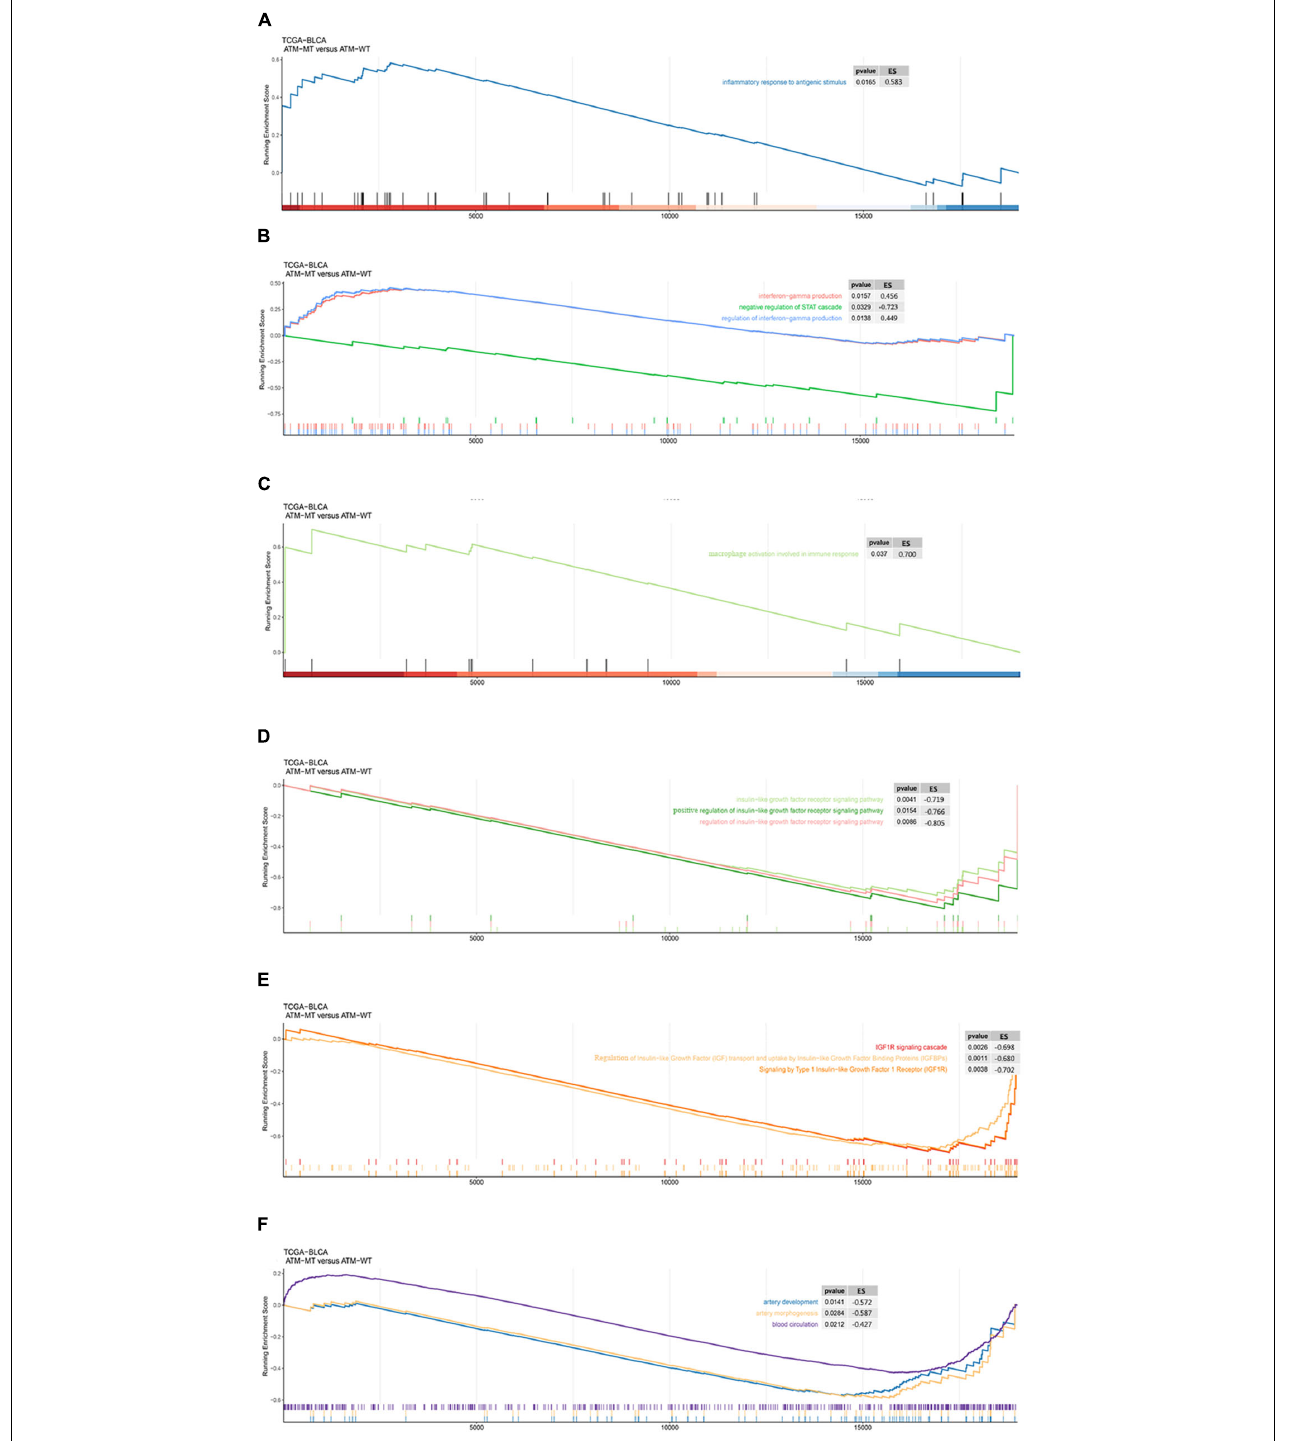
FIGURE 4 | GSEA of the functional enrichment pathways of the ATM-MT and ATM-WT groups in the TCGA-BLCA cohort and GDSC-Bladder cancer cell line dataset. (A) The inflammatory response in the antigen pathway was significantly enriched in the ATM-MT group. (B) Interferon-gamma production and regulation pathways were significantly enriched in the ATM-MT group. (C) Macrophage activation involved in the immune response pathway was significantly enriched in the ATM-MT group. (D) The insulin-like growth factor receptor signaling pathway was significantly downregulated in the ATM-MT group. (E) The insulin-like growth factor receptor signaling pathway was significantly downregulated in the ATM-MT group. (F) Angiogenesis-related pathways were significantly downregulated in the ATM-MT group.